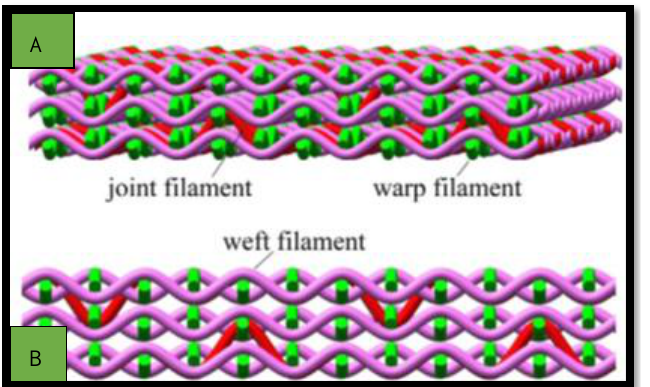
Figure 10. SEM of the SF scaffolds during degradation in 1.0 U/mL protease XIV. ( a ) 1 d, ( b ) 3 d, ( c ) 6 d, ( d ) 12 d, ( e ) 18 d, ( f ) 24 d. Scale bars ¼ 20 mm. Reprinted/adapted with permission from Ref. [79].